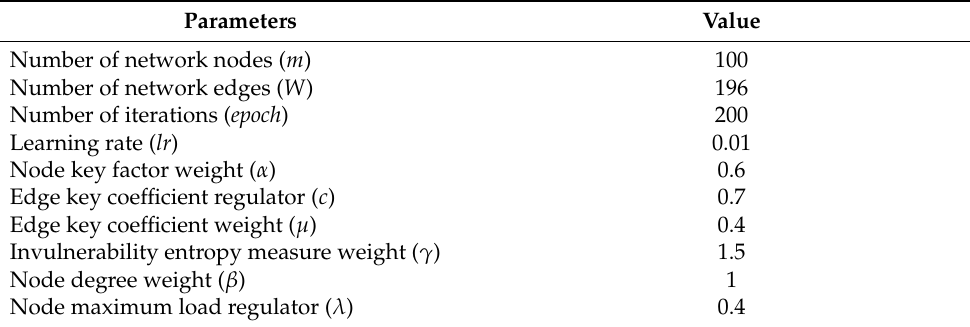
Table 1. Simulation experiment